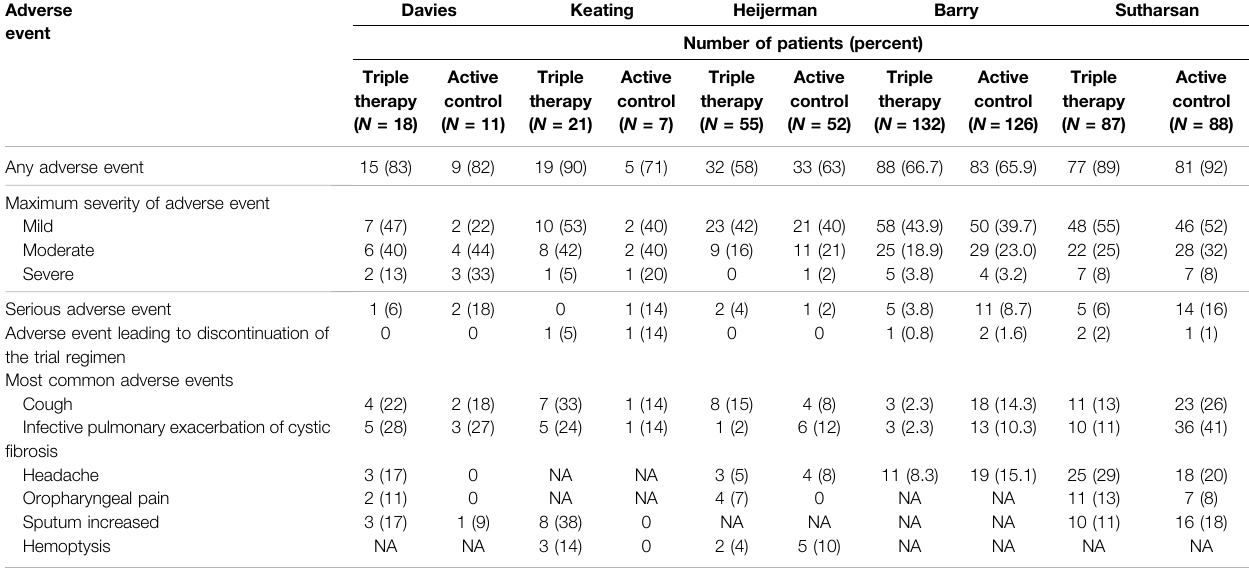
TABLE 3 | Adverse event for active control with all mutation